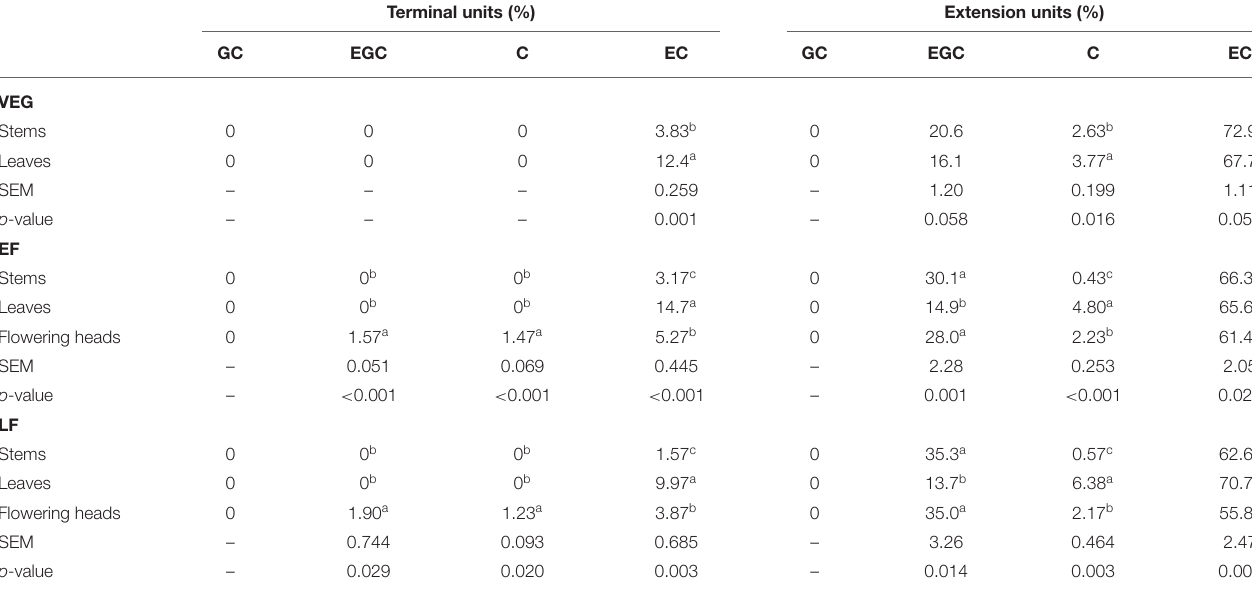
TABLE 2 | Flavan-3-ol composition (mole %) of CT in stems, leaves, and flowering heads of purple prairie clover (PPC) ( Dalea purpurea Vent) harvested at VEG, EF, or LF. Terminal units